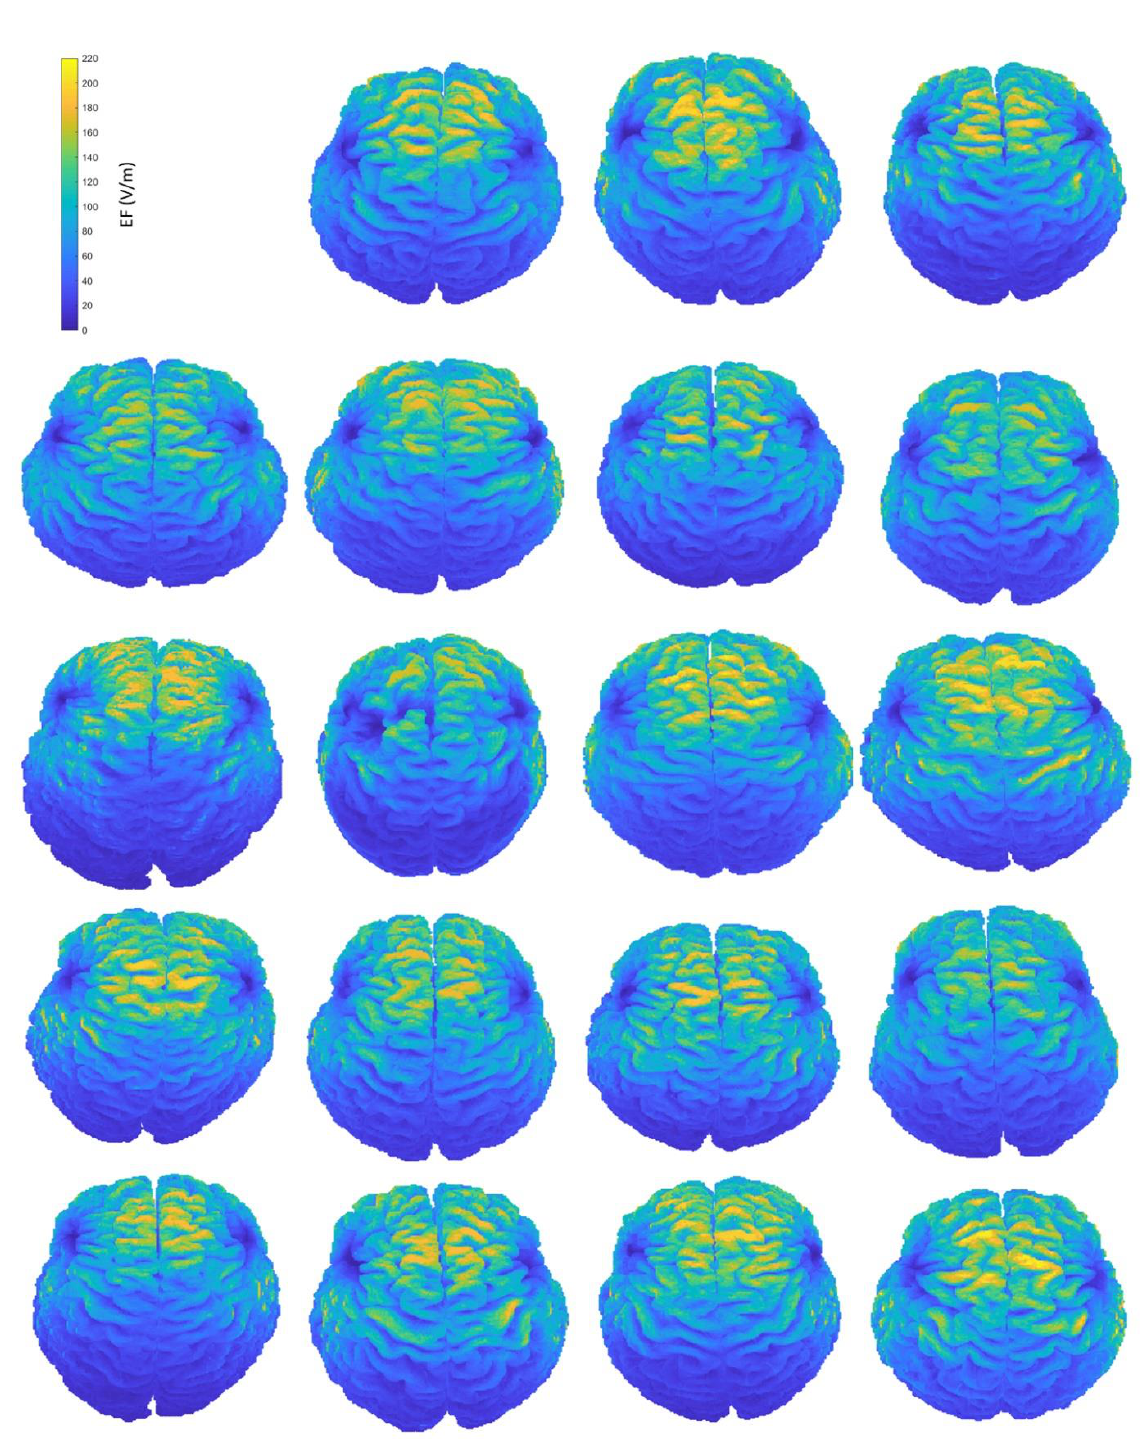
Figure A1. Interindividual variability of the induced EF distributions visualized on subjects’ anatomical brains, containing both grey and white matter, when the coil is placed at frontal position.